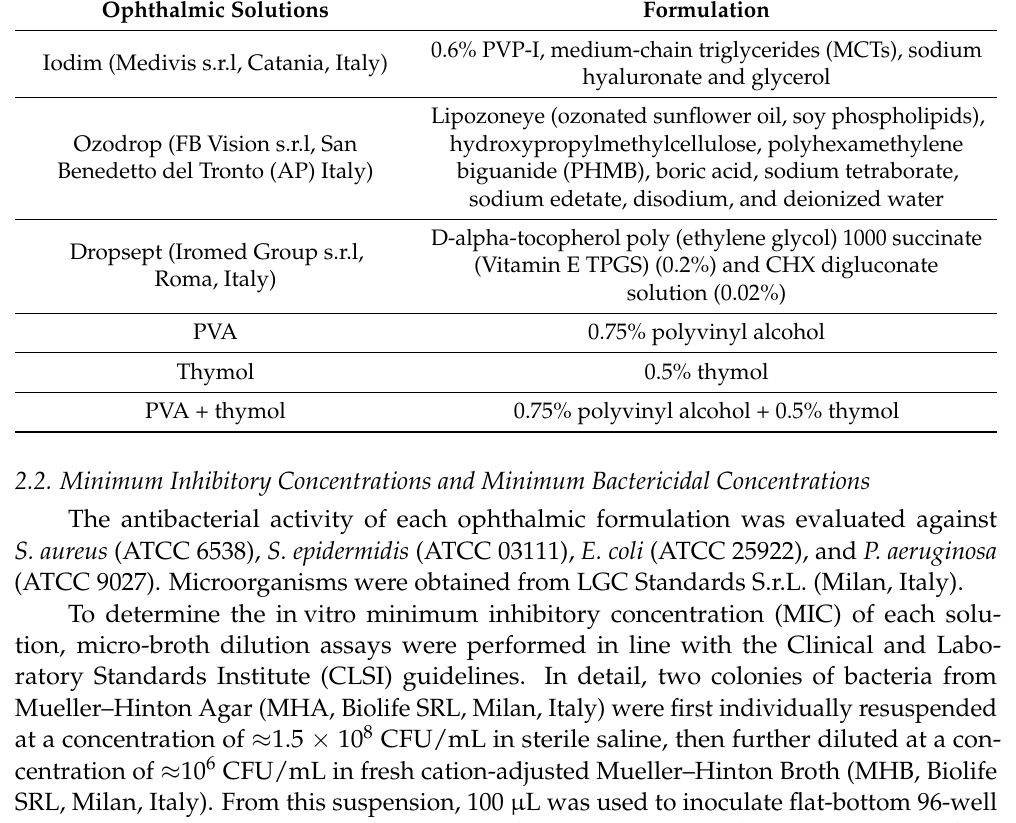
Table 1. List of the ophthalmic solutions. Ophthalmic Solutions